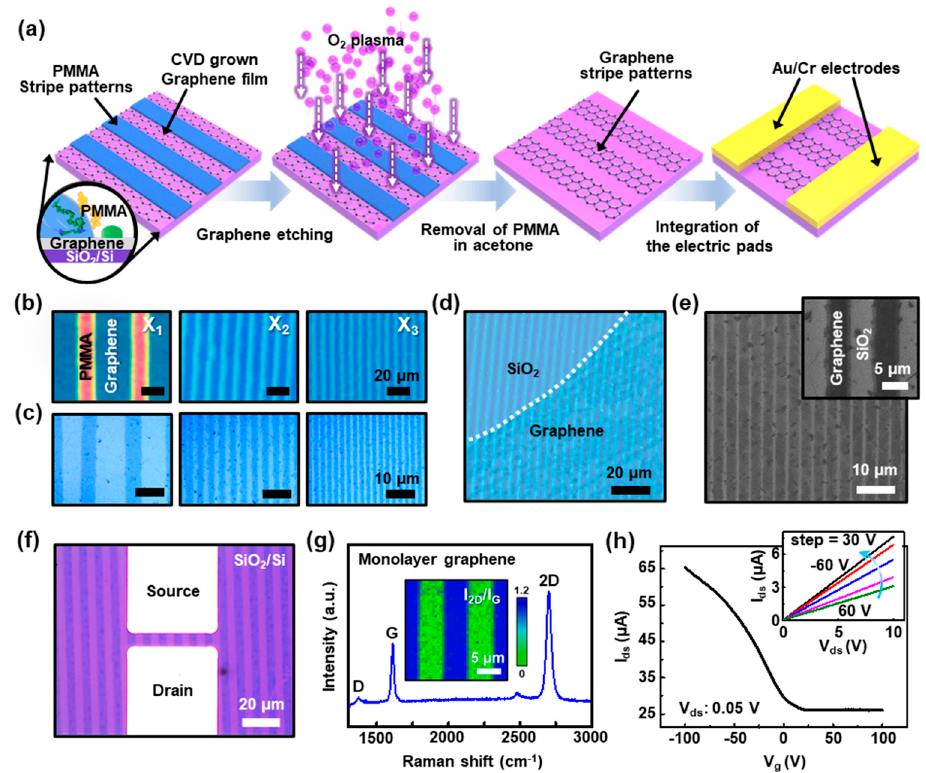
Figure 5. ( a ) Schematic description of a sequential process of patterning chemical vapor deposition (CVD) grown graphene using PMMA stripes as lithographic etch masks to build multichannel graphene field-effect transistors (GFETs). ( b ) A set of optical micrographs of the stripe patterned arrays of PMMA on graphene/SiO 2 /Si substrate; images were collected from the different regions (i.e., X 1 , X 2 , and X 3 ). ( c ) A set of optical micrographs of micropatterned arrays of graphene films after the oxygen plasma and the subsequent removal of PMMA. ( d ) An optical micrograph of highly uniform PMMA stripe patterns formed on the graphene film; the white dotted line indicates the boundary between the graphene film and SiO 2 surface. ( e ) SEM image of stripe patterned graphene arrays on the SiO 2 /Si substrate. ( f ) Typical optical micrograph of a back-gated multichannel GFETs, integrated with Au/Cr contact pads as the source and drain. ( g ) Raman spectrum measured from the graphene stripe on the SiO 2 /Si substrate, which indicates a monolayer in the graphene structure; the inset shows a Raman mapping image of the patterned graphene films. ( h ) Drain current ( I ds ) as a function of gate voltage ( V g ) for a source/drain bias ( V ds ) of 0.05 V; the inset shows an output characteristic of GFETs.